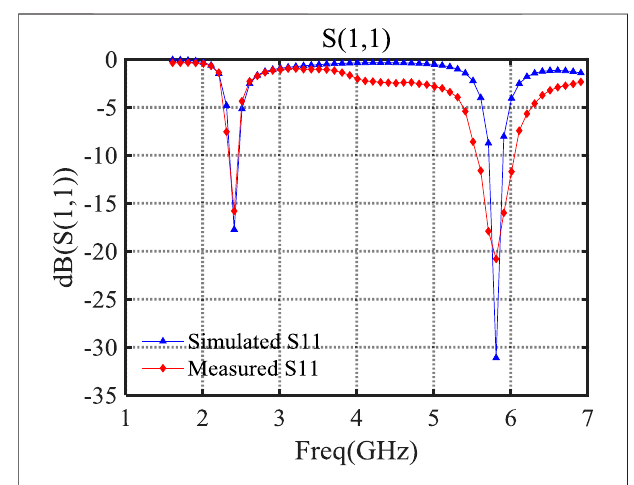
FIGURE 5 | Re fl ection coef fi cient of the wearable